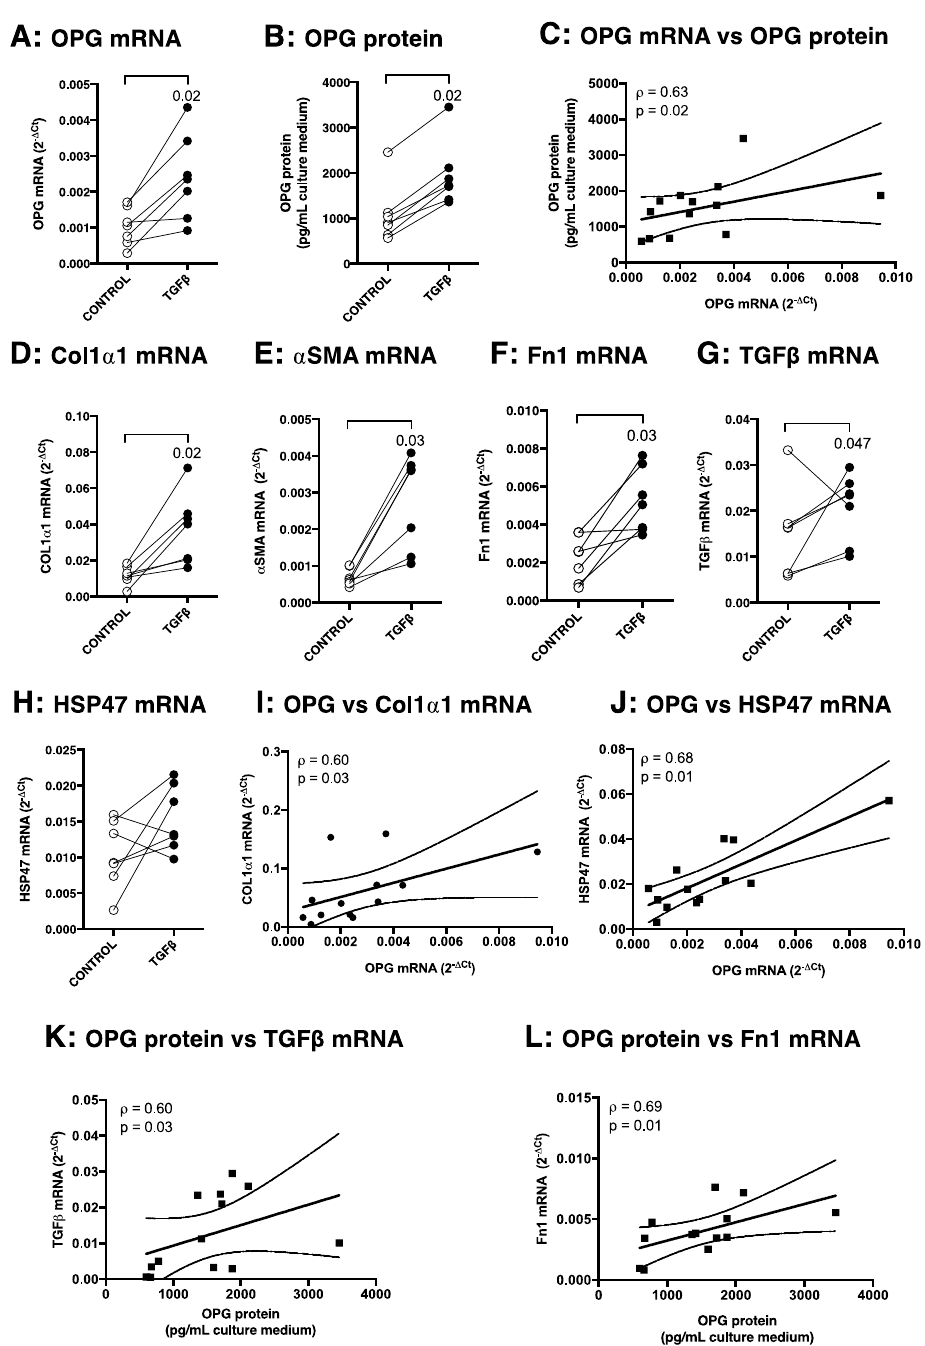
Figure 4. TGF β 1 induces OPG expression as well as various fibrosis-associated markers in murine liver slices. When murine liver slices were treated with 5 ng / mL TGF β 1, significantly more OPG mRNA ( A ) and OPG protein excretion ( B ) were observed, which correlated closely with each other ( C , Spearman ρ = 0.63, p = 0.02). This higher OPG production was accompanied by higher mRNA expression levels of fibrosis-associated markers Col1 α 1 ( D ), α SMA ( E ), Fn1 ( F ), and TGF β 1 ( G ), but not HSP47 ( H ). OPG mRNA expression correlated closely with Col1 α 1 ( I ) and HSP47 ( J ) mRNA expression, while OPG protein secretion correlated with TGF β 1 ( K ) and Fn1 (L) mRNA expression. Groups were compared using Wilcoxon, correlations were calculated using a Spearman correlation test, and p < 0.05 was considered significant. For the correlations, data from control and TGF β 1-stimulated slices of Figure 5 were also added.